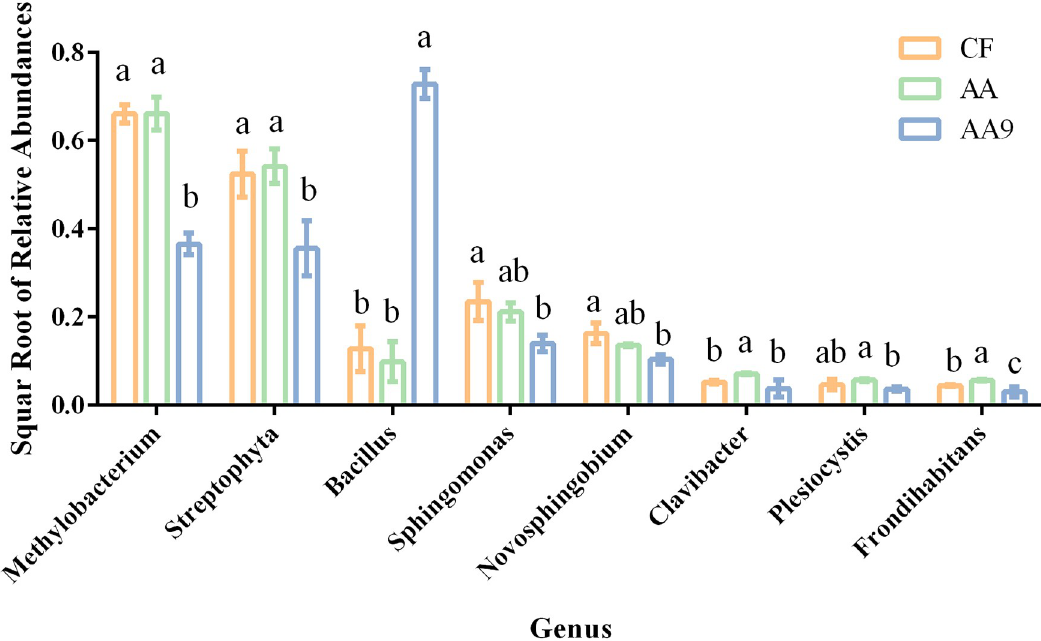
Fig 5. Microbial composition variation. Square root of the relative abundances (Mean ± SD, n = 3) of different genera with significant differences in different treatments. CF, treatment sprayed with chemical fertilizer; AA, treatment sprayed with amino acids liquid fertilizer; AA9, treatment sprayed with liquid biological fertilizer. Different letters in the same line indicate significant differences as defined by Duncan’s test ( P < 0.05).